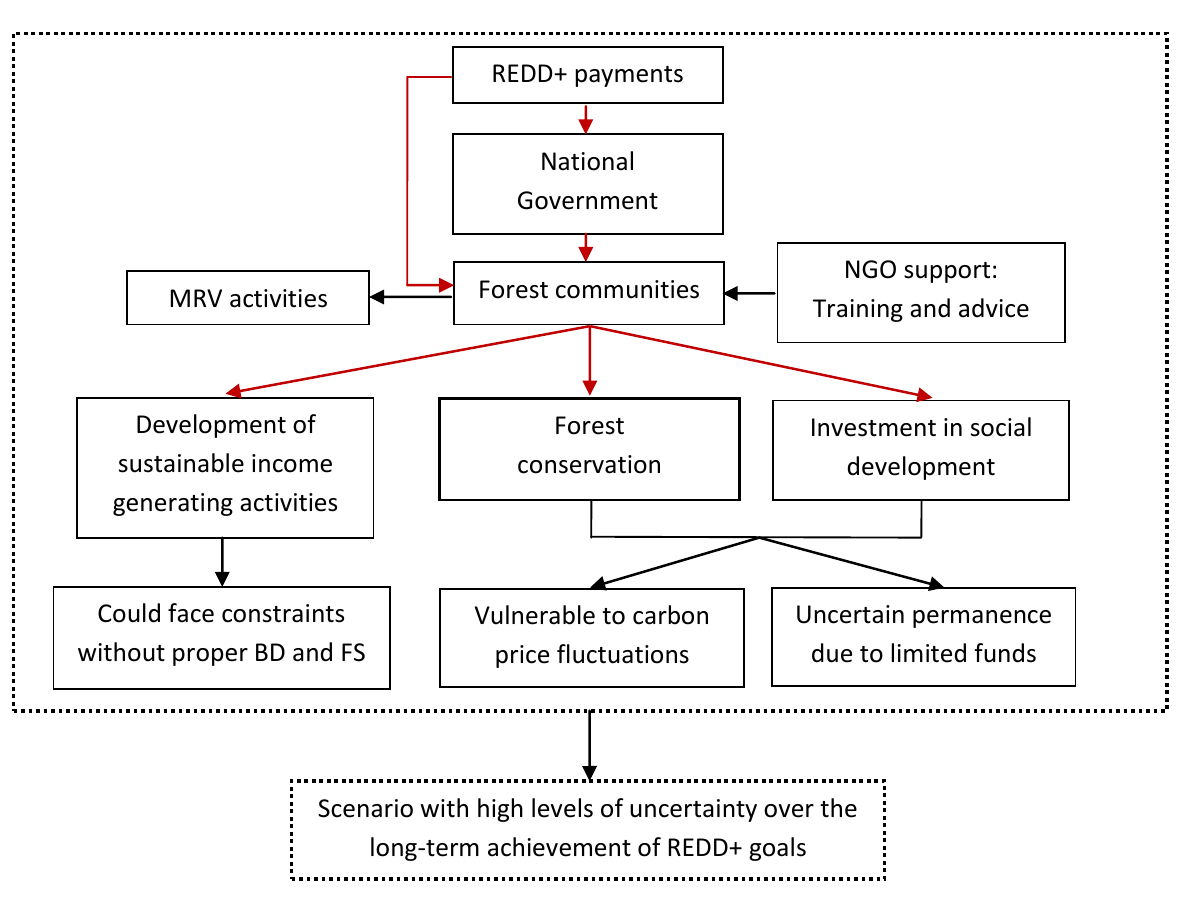
Figure 1. Possible Scenario 1—the conventional